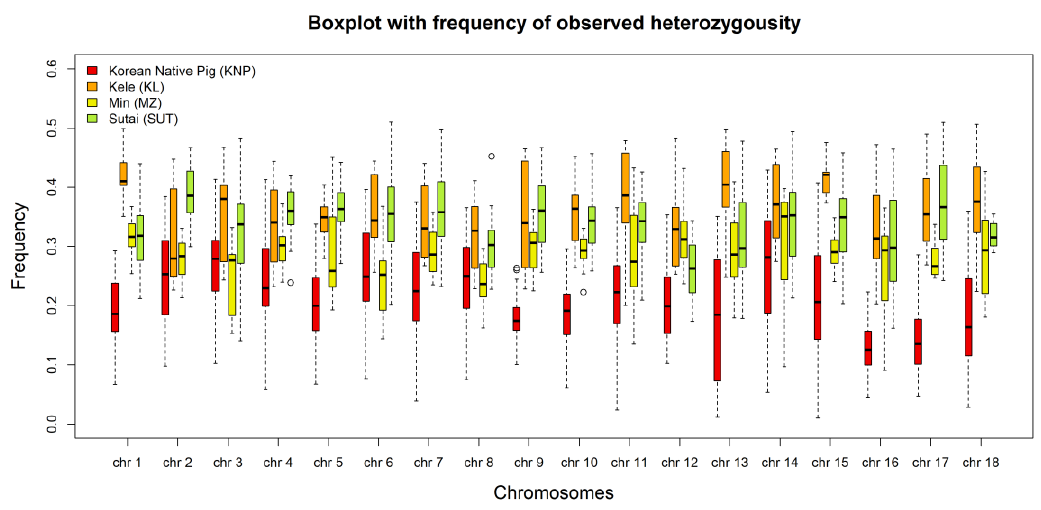
Figure 7. Box plot of H O values for the KNP, KL, MZ, and SUT breeds by chromosome.